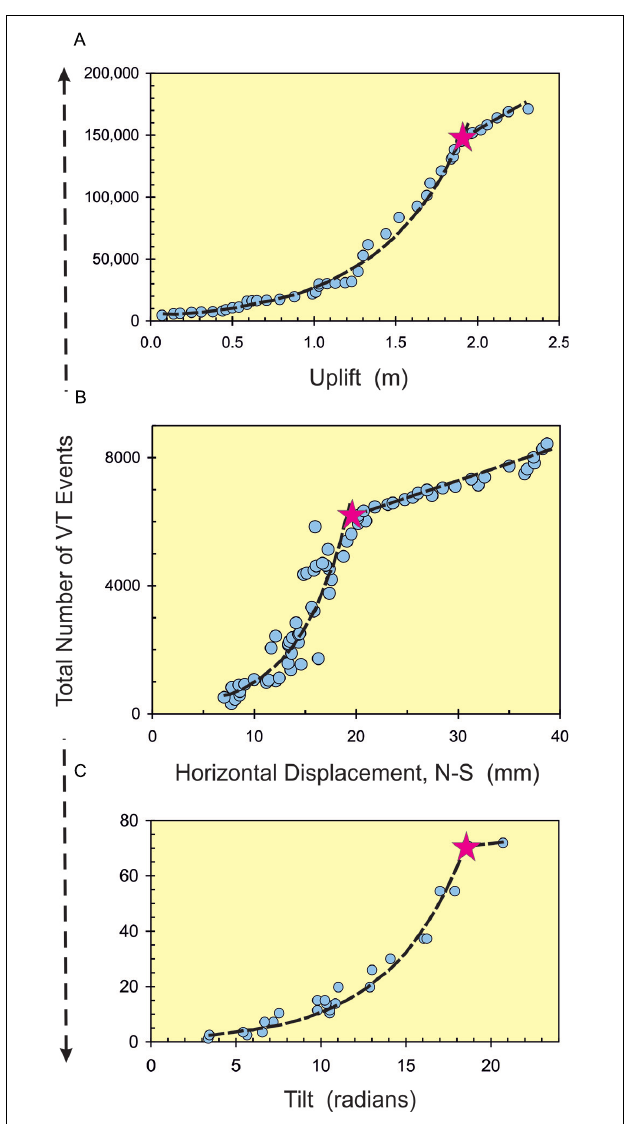
FIGURE 5 | Changes in the total number of VT events with deformation for precursors to eruption at (A) Rabaul, Papua New Guinea, 1971–1994 [data from Robertson and Kilburn (2016)]: (B) El Hierro, Canary Islands, 18 July–12 October 2011 [data from Istituto Geográfica Nacional [IGN] (2011) and Sagiya (2011)]; and (C) Mauna Ulu, Kilauea, Hawaii, 14 November 1971–04 February 1972, [data from Bell and Kilburn (2011)]. The quasi-elastic regime shows exponential trends between VT number and the proxy for deformation, yielding characteristic values of 0.53 m for uplift at Rabaul [ (cid:54) N ∝ exp ( λ /0.53)], 5 mm for displacement at El Hierro [ (cid:54) N ∝ exp ( λ /5)] and 4.5 rad for tilt at Kilauea [ (cid:54) N ∝ exp ( λ /4.5)]. The inelastic regime shows linear trends. The data are consistent with transition between regimes ( star ) when the ratio of total deformation to characteristic value ( λ / λ ch ) is about 4. See Figure 4 for the normalized